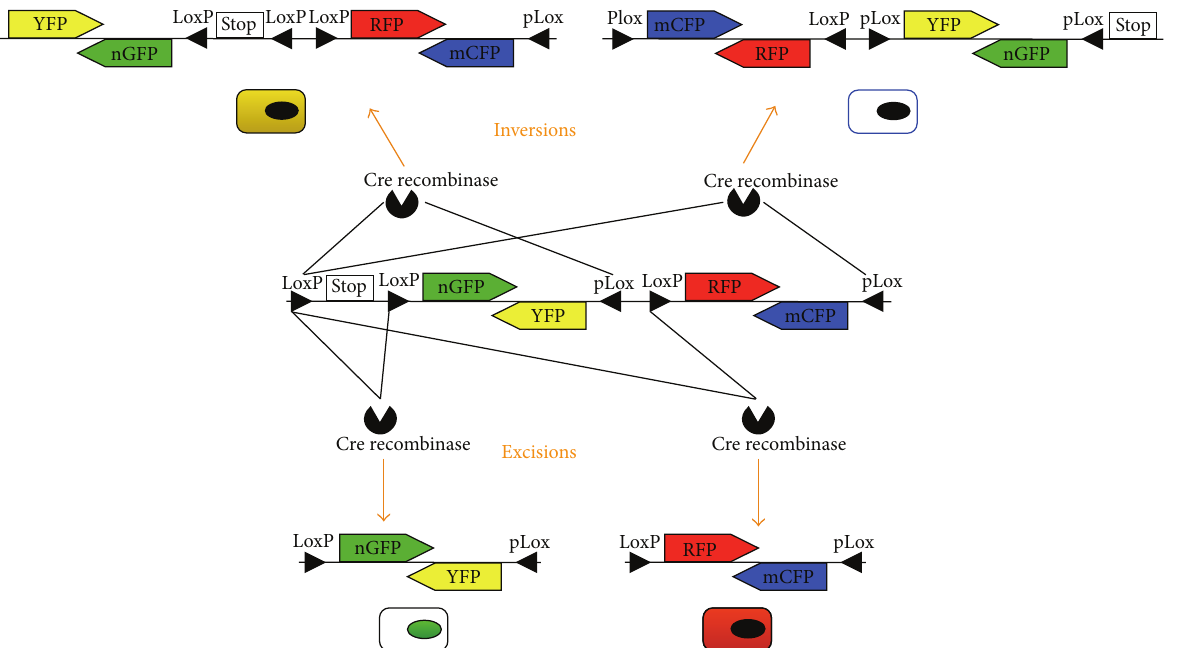
Figure 2: Schematic overview of the Confetti reporter system. In the center, the whole construct. On the bottom, excision eliminates reporter gene thus turning on one cell color. On the top, inversions rely on pLox sites that are used to invert the construct favoring other colors (Cre recombinase inverts segments floxed between two LoxP sites oriented in a head-to-head fashion). Both inverted and excised fragments can continue to invert as long as there is Cre activity, since LoxP sites are excised, while pLox sites are not. Consequently, an inducible model might be best suitable to stabilize cell color following inductor molecule removal. All recombinatorial events that do not involve the LoxP site upstream to the Stop cassette would result in no color acquisition by the